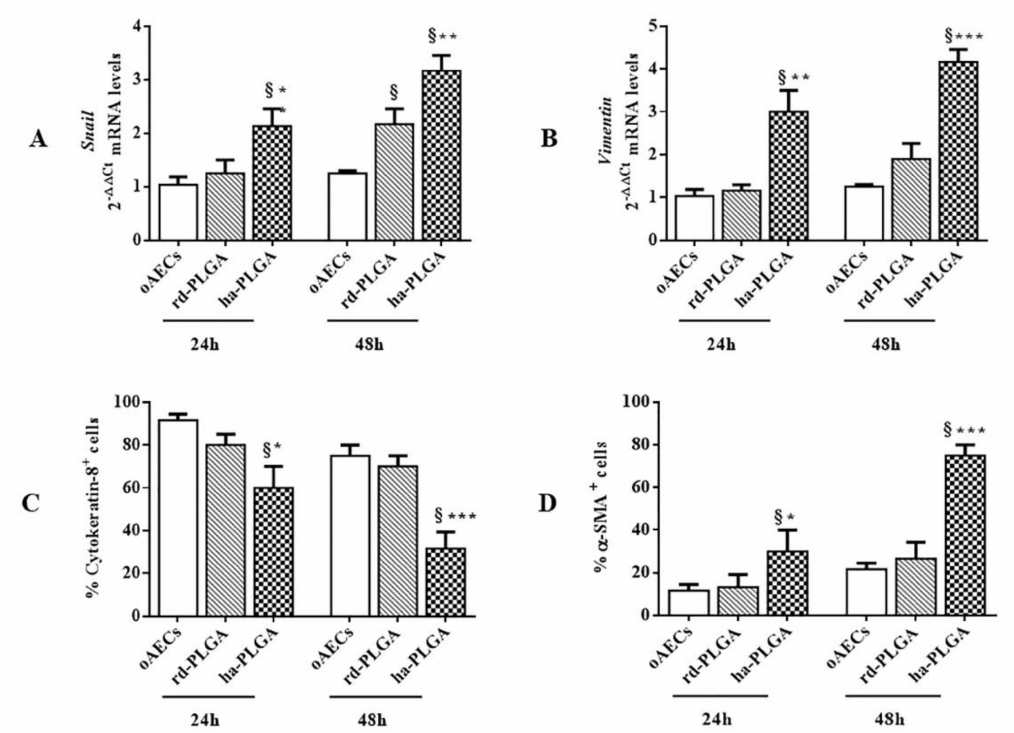
Figure 6. Epithelial-Mesenchymal Transition (EMT) gene and protein expression in oAECs cultured on Petri dishes or onto electrospun rd-PLGA and ha-PLGA fleeces after 24 h and 48 h. Results show that electrospun ha-PLGA fleeces were able to modulate oAEC phenotype by accelerating the EMT. Quantitative RT-PCR data show a significantly higher expression of ( A ) Snail and ( B ) Vimentin mRNA expression when oAECs are seeded onto ha-PLGA compared to the other groups. Immunohistochemistry (IHC) analysis was used to evaluate EMT by quantifying the percentage of positive cells for ( C ) Cytokeratin-8 and ( D ) α -SMA protein expression * Statistically significant between ha-PLGA and rd-PLGA ( p < 0.05). ** Statistically significant between ha-PLGA and rd-PLGA ( p < 0.01). *** Statistically significant between ha-PLGA and rd-PLGA ( p < 0.001). § Statistically significant between ha-PLGA and oAECs ( p < 0.001). (n = 3 for each type of sample / analysis / time point, scaffold size: 15 mm × 7